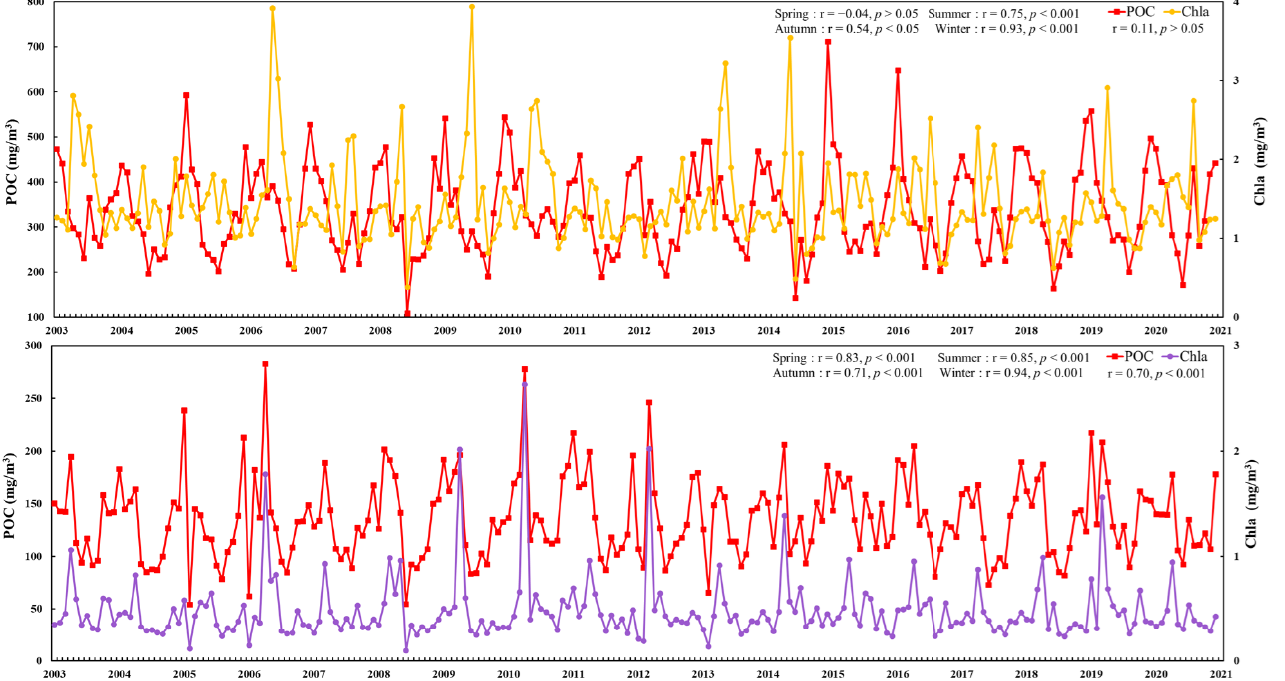
Figure 8. Time series of the monthly mean surface concentration of POC and chlorophyll-a in the Changjiang Estuary ( upper ) and the East China Sea ( bottom ) from 2003 to 2020, respectively.